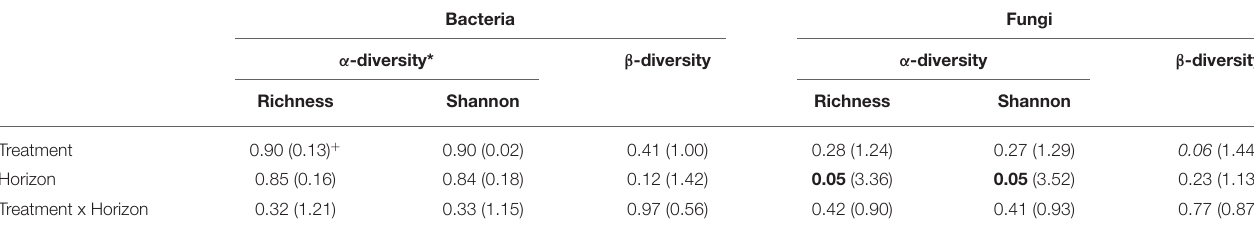
TABLE 2 | Treatment (N addition) and spatial (horizon) effects on α -diversity (Richness and Shannon Index) and ß-diversity (Bray-Curtis dissimilarities) in the Alptal N addition